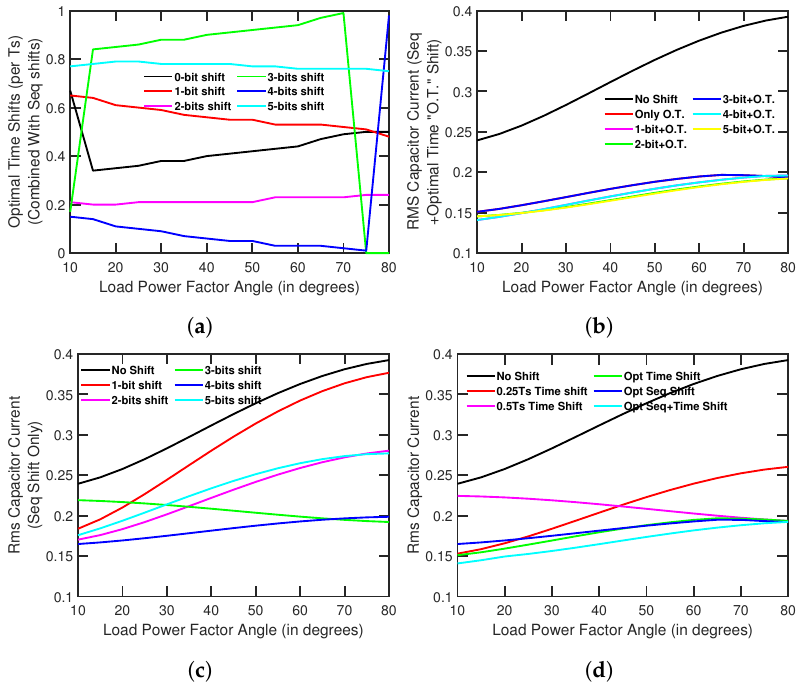
Figure 9. For equal load and mod.index = 1. ( a ) Optimal time shifts (combined with seq shifts). ( b ) i c,rms for seq+opt time shifts. ( c ) i c,rms for only seq shifts. ( d ) Comparative i c,rms for different interleaving shifts.